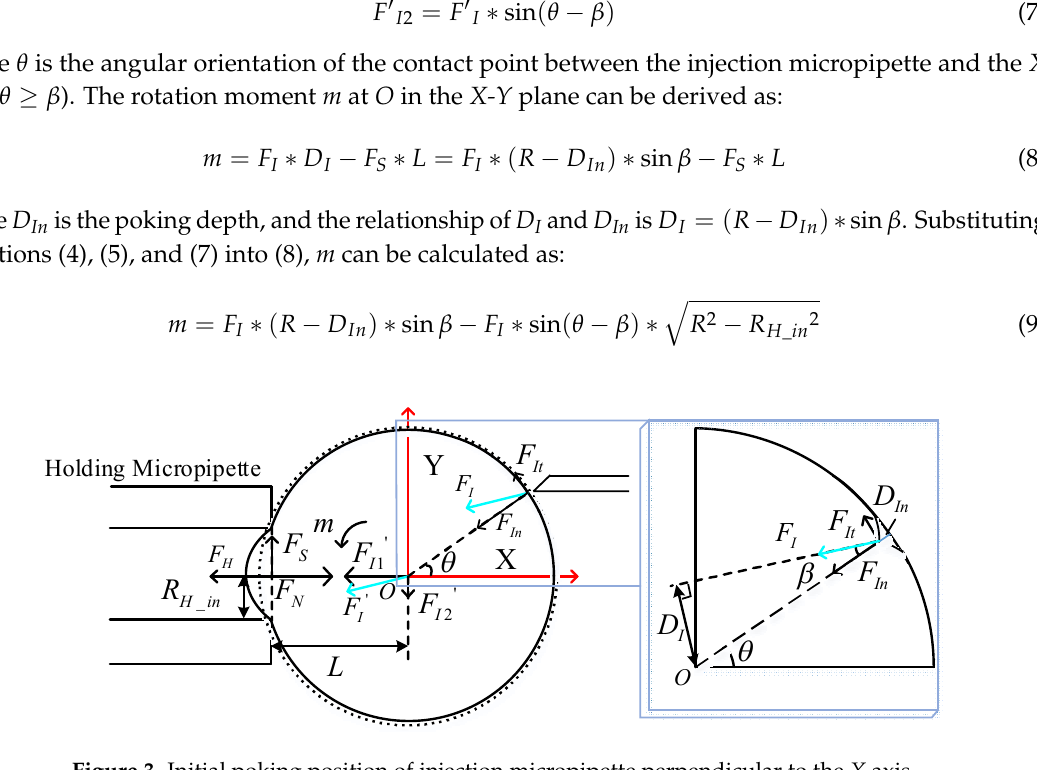
Figure 3. Initial poking position of injection micropipette perpendicular to the X axis.